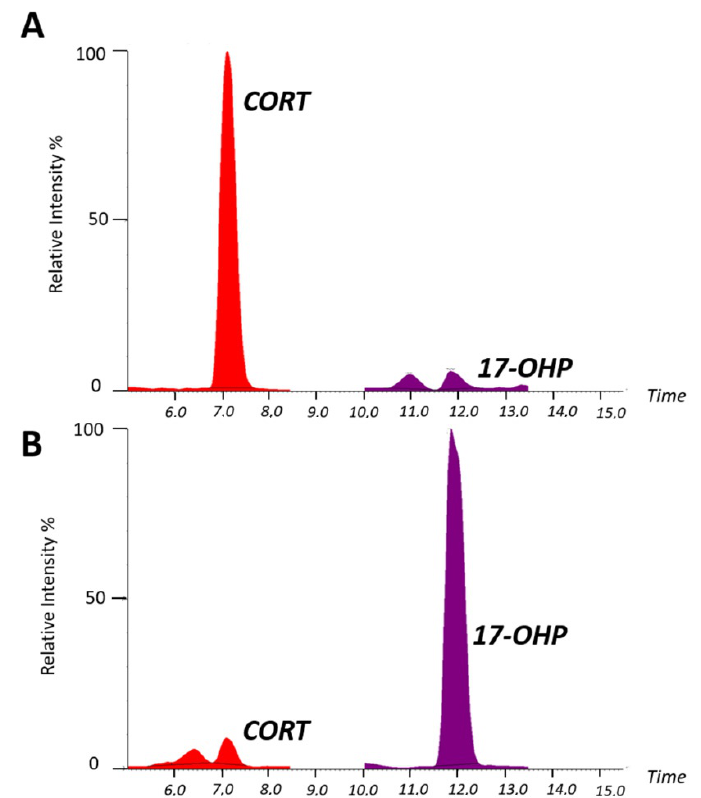
Figure 1. Steroid chromatographic profile. The chromatogram shows the main differences in the serum steroid profile for a normal control sample (Panel ( A )) and for the sample from the neonatal patient with congenital adrenal hyperplasia (CAH; Panel ( B )).